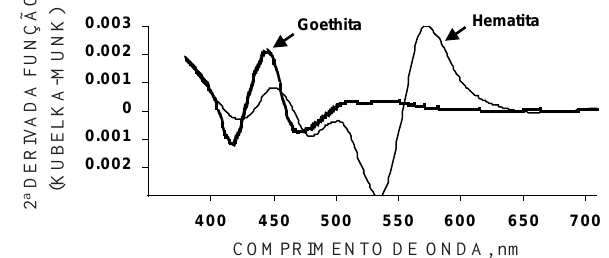
Figura 7. Espectros da segunda derivada da função Kubelka-Munk de óxidos de ferro sintéticos (adaptação de Chavernas, 1996).